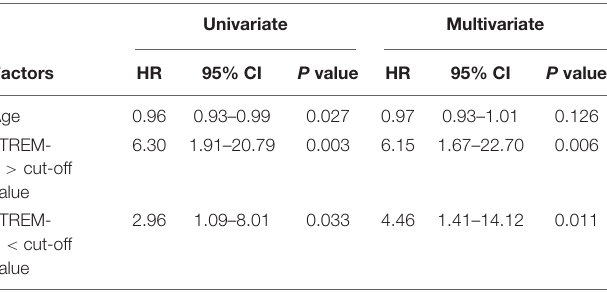
TABLE 4 | Cox proportional hazards analysis of risk factors for SARs.